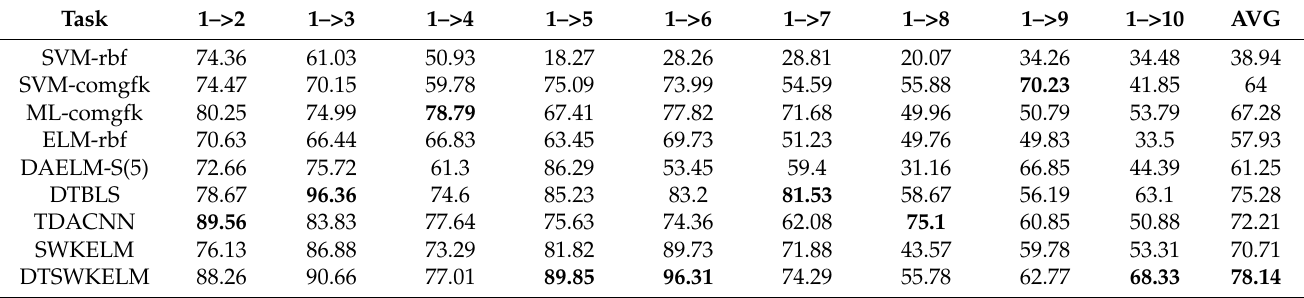
Table 2. The recognition effect of each algorithm in Experiment 1